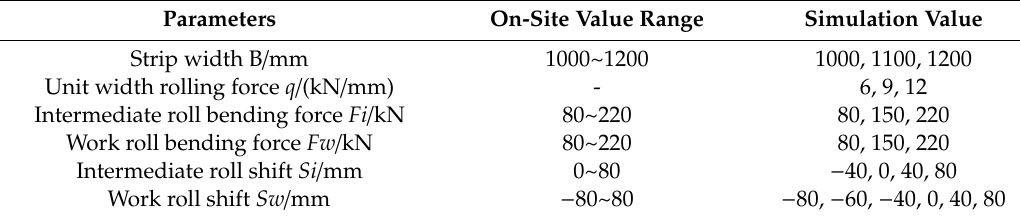
Figure 4. Roll shift amount. ( a ) Zero shifting roll position, ( b ) positive shifting roll position. Table 3. Simulation condition.